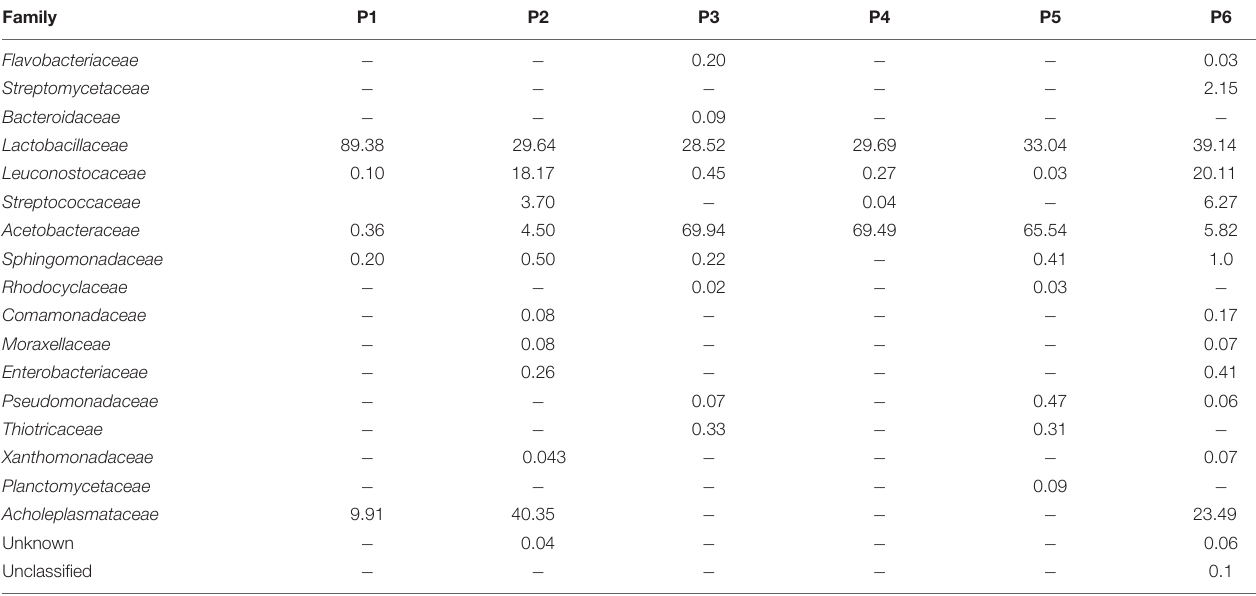
TABLE 4 | Bacterial community diversity in six samples of Masa Agria from different producers ( P ,